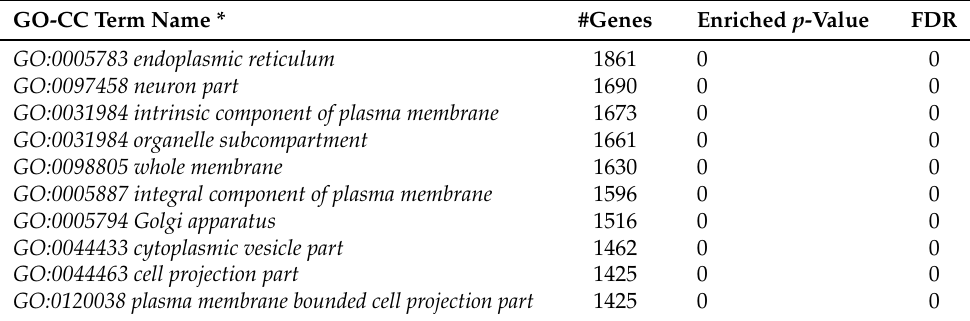
Table 7. Top significant GO-CC term enriched (FDR sorted).